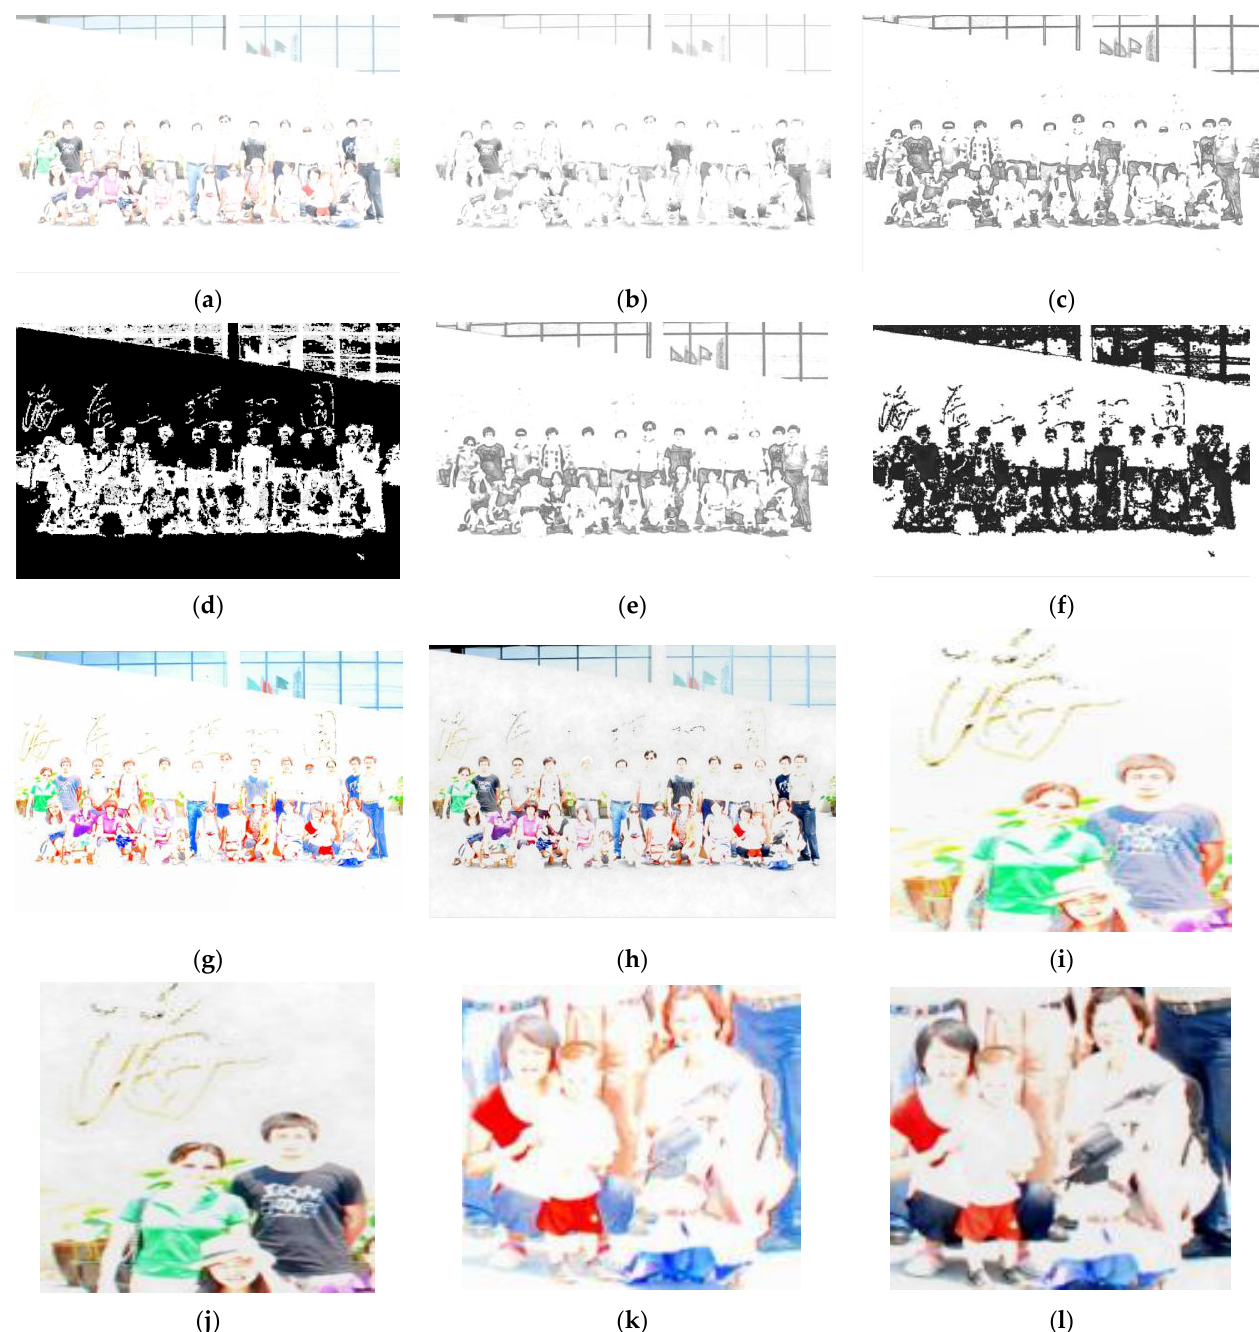
by Formula (6), Figure 3h generated by our algorithm is better in terms of its color, visual effect and detail processing. The detailed comparison is shown in Figure 3i–l.